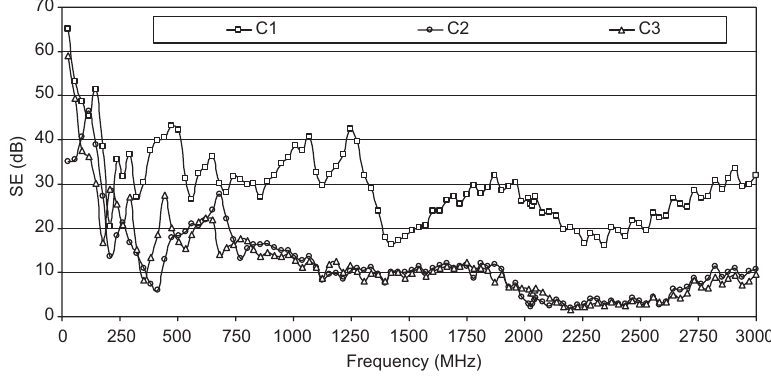
Figure 6 EMSE values of C1 to C3 composite laminates.